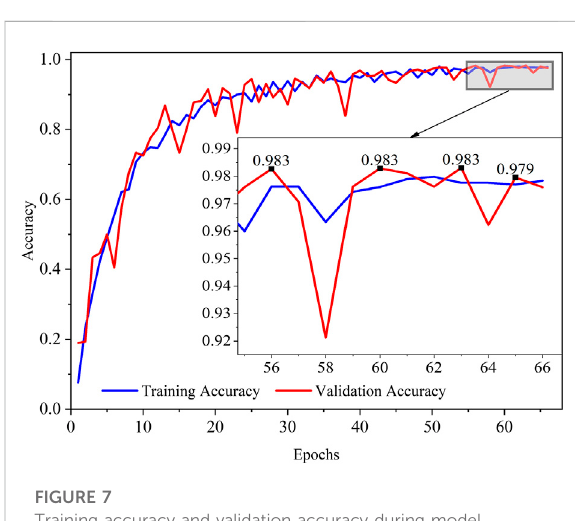
FIGURE 7 Training accuracy and validation accuracy during model